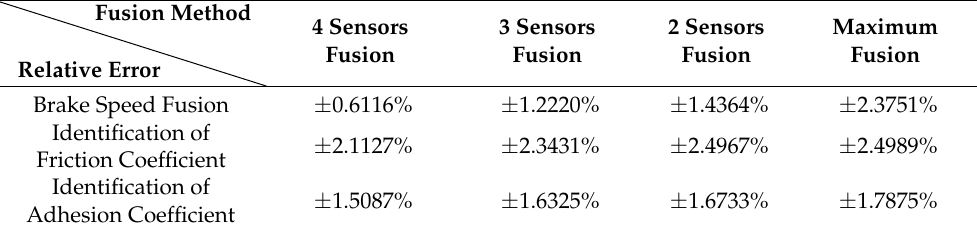
Table 6. Speed fusion errors and parameter identification